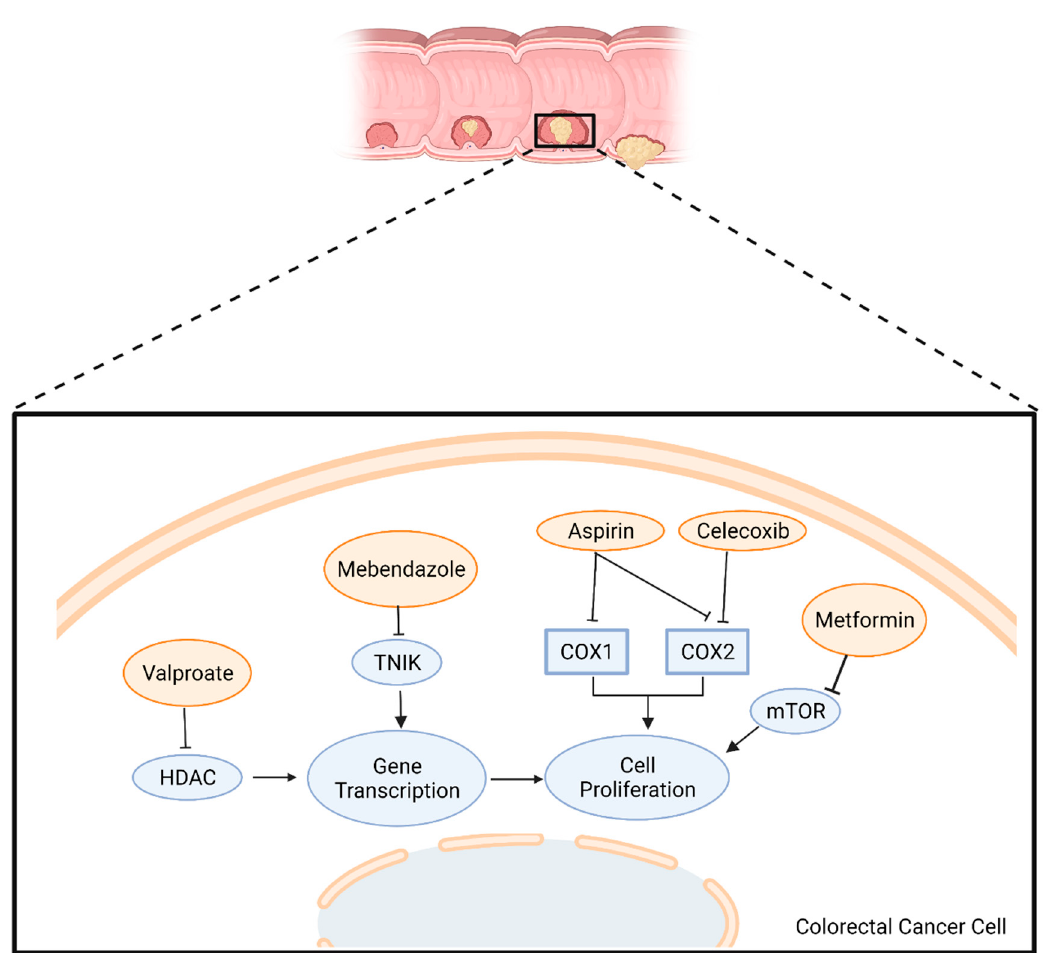
Figure 1. Mode of action of candidate repurposed drugs being tested in clinical trials for patients with CRC. HDAC: Histone Deacetylase; TNIK: TRAF2 And NCK Interacting Kinase; COX: Cyclo- oxygenase; mTOR: mammalian Target of Rapamycin. Adapted from “Round-Cell Background”, by BioRender.com (2022). Retrieved from https://app.biorender.com/biorender-templates accessed on